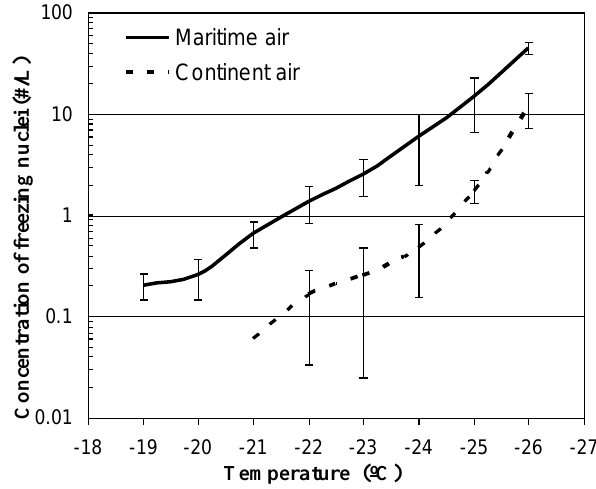
Fig. 9: Comparison between measurements taken on the rooftop based on air Fig. 9. Comparison between measurements taken on the rooftop trajectory calculations. The solid curve represents ice nuclei concentrations in based on air trajectory calculations. The solid curve represents ice maritime air mass as measured from filters 1-4 and 8. The dashed curve is for ice nuclei concentrations in maritime air mass as measured from fil- nuclei concentrations in continental air mass as measured from filters 9-12. See text for definition of maritime and continental air. Bars represent the standard deviation. ters 1–4 and 8. The dashed curve is for ice nuclei concentrations in continental air mass as measured from filters 9–12. See text for def- inition of maritime and continental air. Bars represent the standard